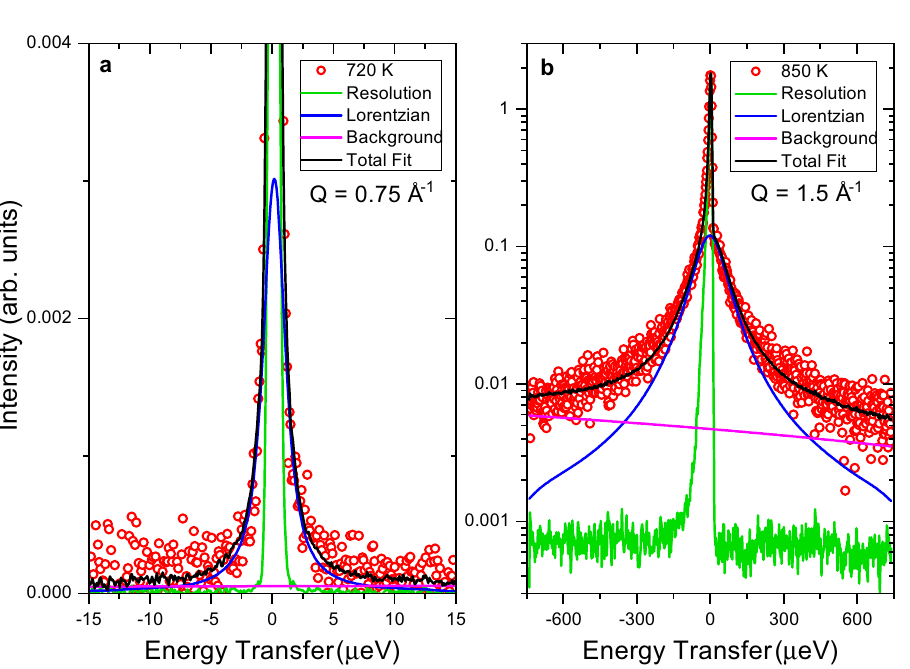
Figure 2. QENS spectra measured at ( a ) HFBS at Q = 0.75 Å -1 and T = 720 K (orthorhombic phase) and ( b ) measured at BASIS at Q = 1.5 Å -1 at T = 850 K (hexagonal phase) with the fit components